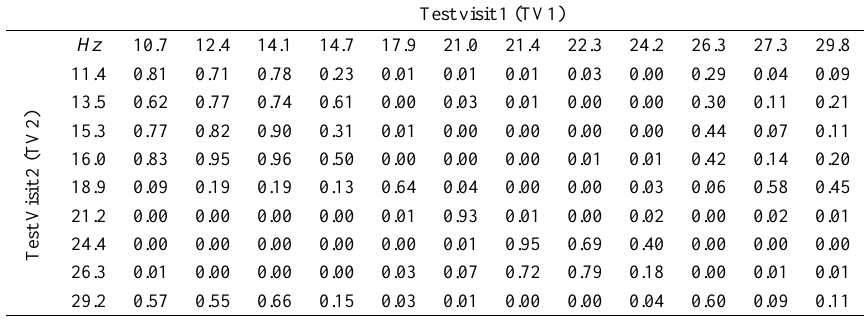
Matrix of MAC values arising from a comparison of first floor slab modes from TV1 to TV2